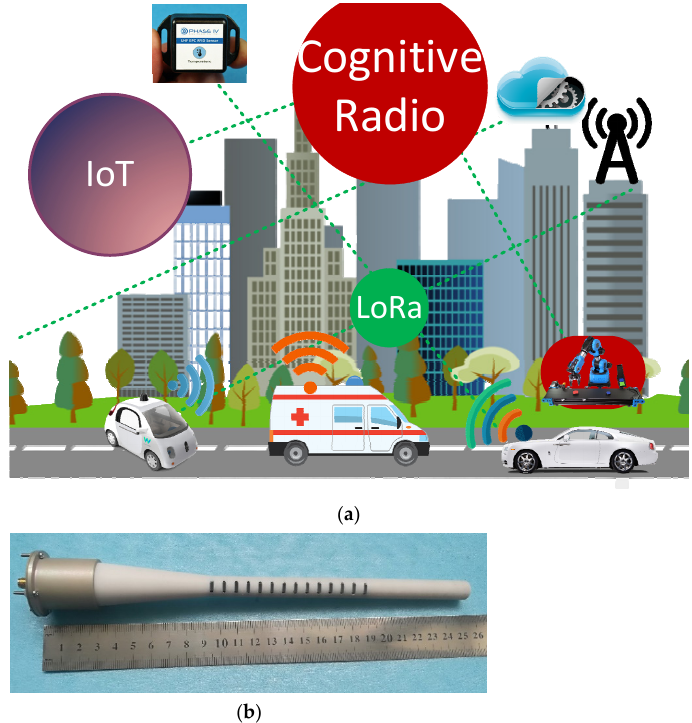
Figure 1. ( a ) Application areas of proposed antenna ( b ) Fabricated prototype of Embedded Helix and dielectric rod antenna.